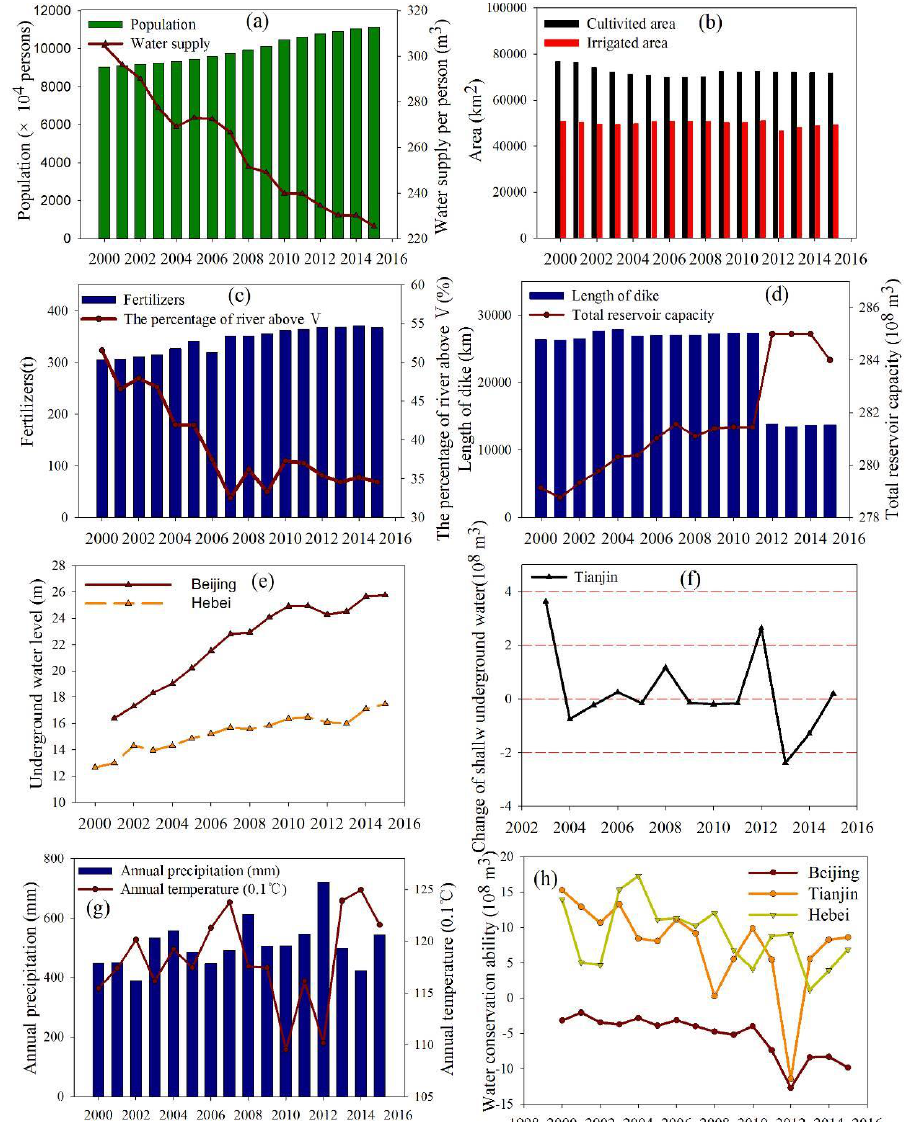
Figure 7. Changes in the environmental variables used in the Beijing-Tianjin-Hebei region (BTH) from 2000 to 2015. (a):population and water supply in BTH, (b):cultivated and irrigated area in BTH, (c):fertilizers and the percentage of river above grade Ⅴ in BTH ， (d):length of dikes and total reservoir capacity in BTH, (e): underground water level in Beijing and Hebei, (f):change of shallow groundwater in Tianjin, (g):annual precipitatiopn and temperature in BTH, (h): water conservation ability in Beijing, Tianjin and Hebei.